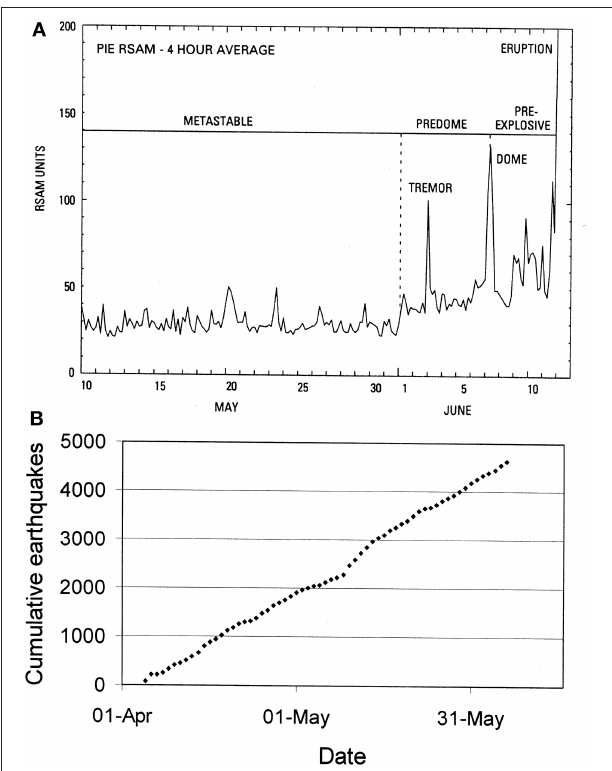
FIGURE 3 | (A) RSAM values from station PIE on Mt. Pinatubo in May-June 1991. Note the stability in May and the increases in early-mid June. From Harlow et al. (1996) and reproduced courtesy of the University of Washington Press. (B) Cumulative earthquake totals recorded at Yamut station on Mt. Pinatubo from 5 April to 6 June 1991. Note the steady accumulation of earthquakes during this time. Data from Sabit et al.